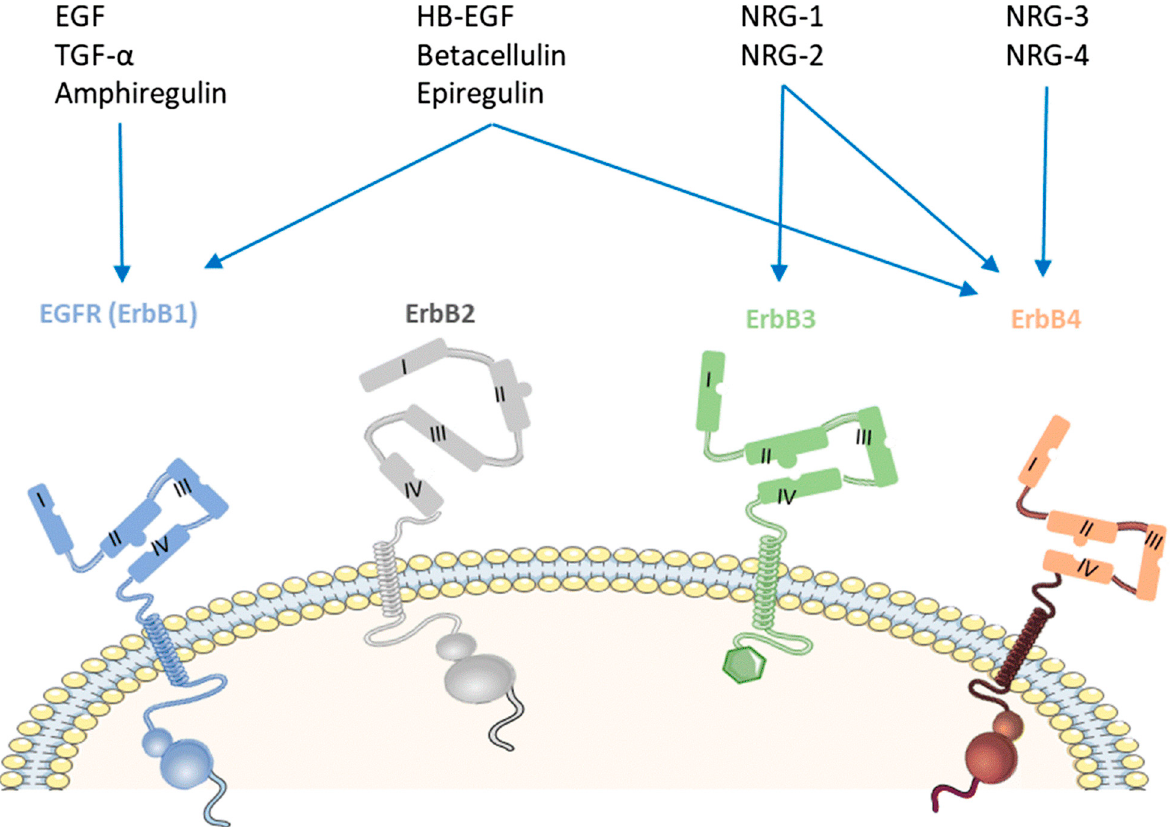
Figure 1. The four members of epidermal growth factor [2]. Reprinted with permission from ref. [2]. Copyright 2020 Springer Nature.